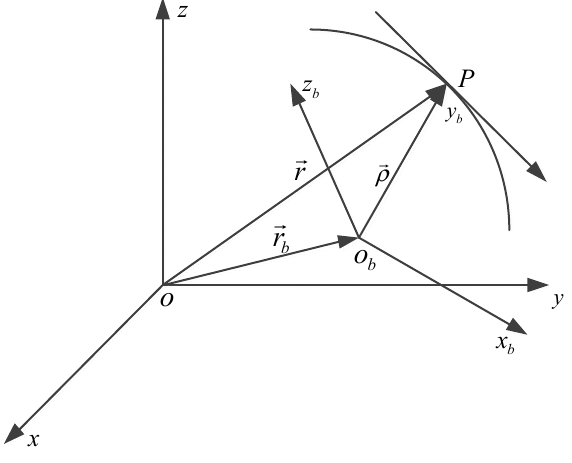
Figure 1. The coordinate systems.